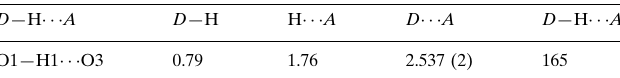
Hydrogen-bond geometry (A˚ , (cid:2)